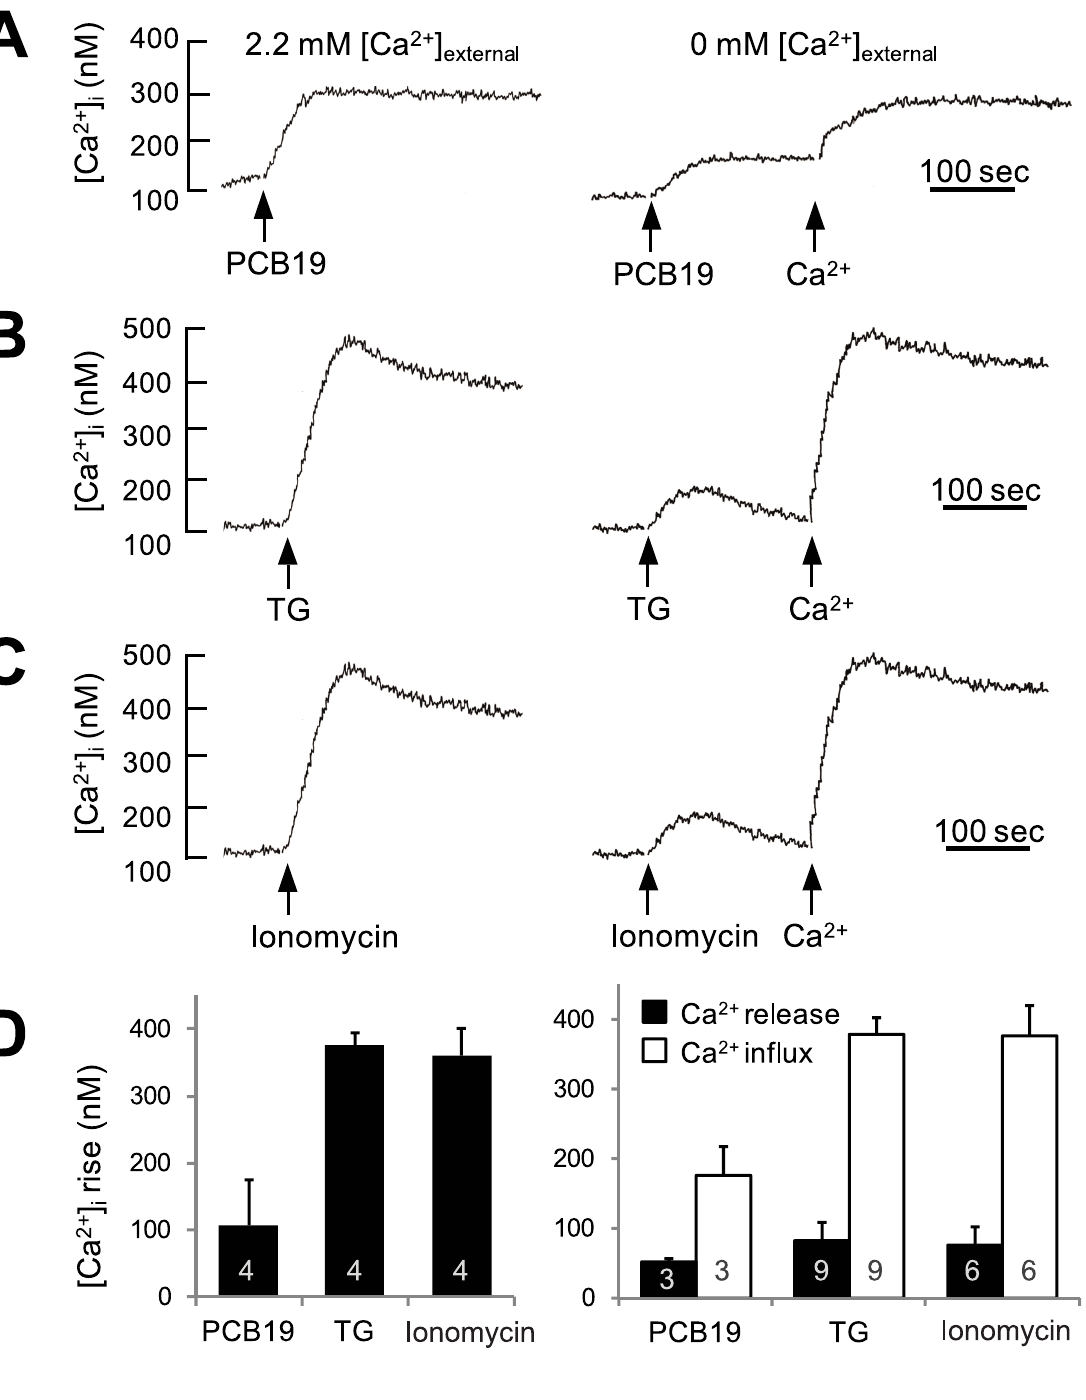
Fig 4. Ca 2+ influxes stimulated by PCB19 are relatively small compared to those stimulated by intracellular Ca 2+ -mobilizing chemicals. A , Fura- 2-loaded PC12 cells were challenged with 50 μ M PCB19 in the presence (left) or absence (right) of 2.2 mM extracellular free Ca 2+ . Ca 2+ increases were also monitored upon reintroduction of 2.2 mM CaCl 2 in the condition lacking extracellular Ca 2+ . B and C, Experiments were performed as in ( A ), but with the addition of 1 μ M thapsigargin (B) or 300 nM ionomycin (C). D, Peak height of [Ca 2+ ]i increase was monitored and represented as mean ± SEM. E and F, Cells were treated with 300 nM ionomycin in the absence of extracellular free Ca 2+ with (gray trance) or without (black trace) the pretreatment of 50 μ M